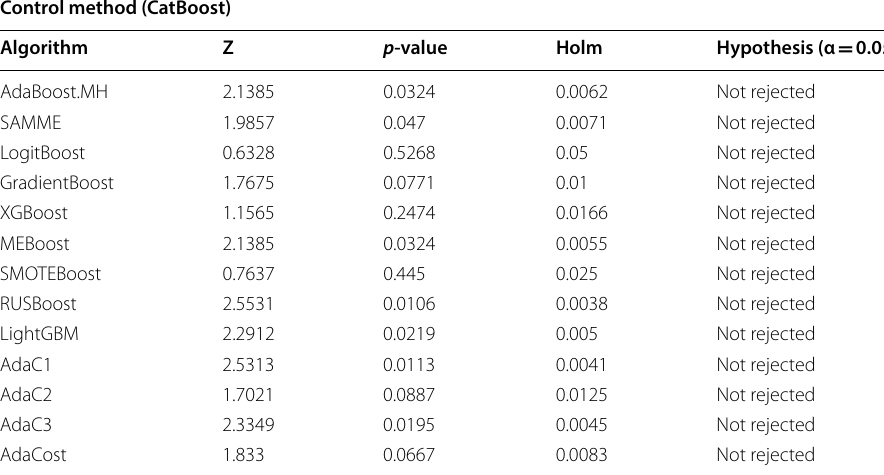
Table 12 Holm post-hoc test results based on the G -means Control method